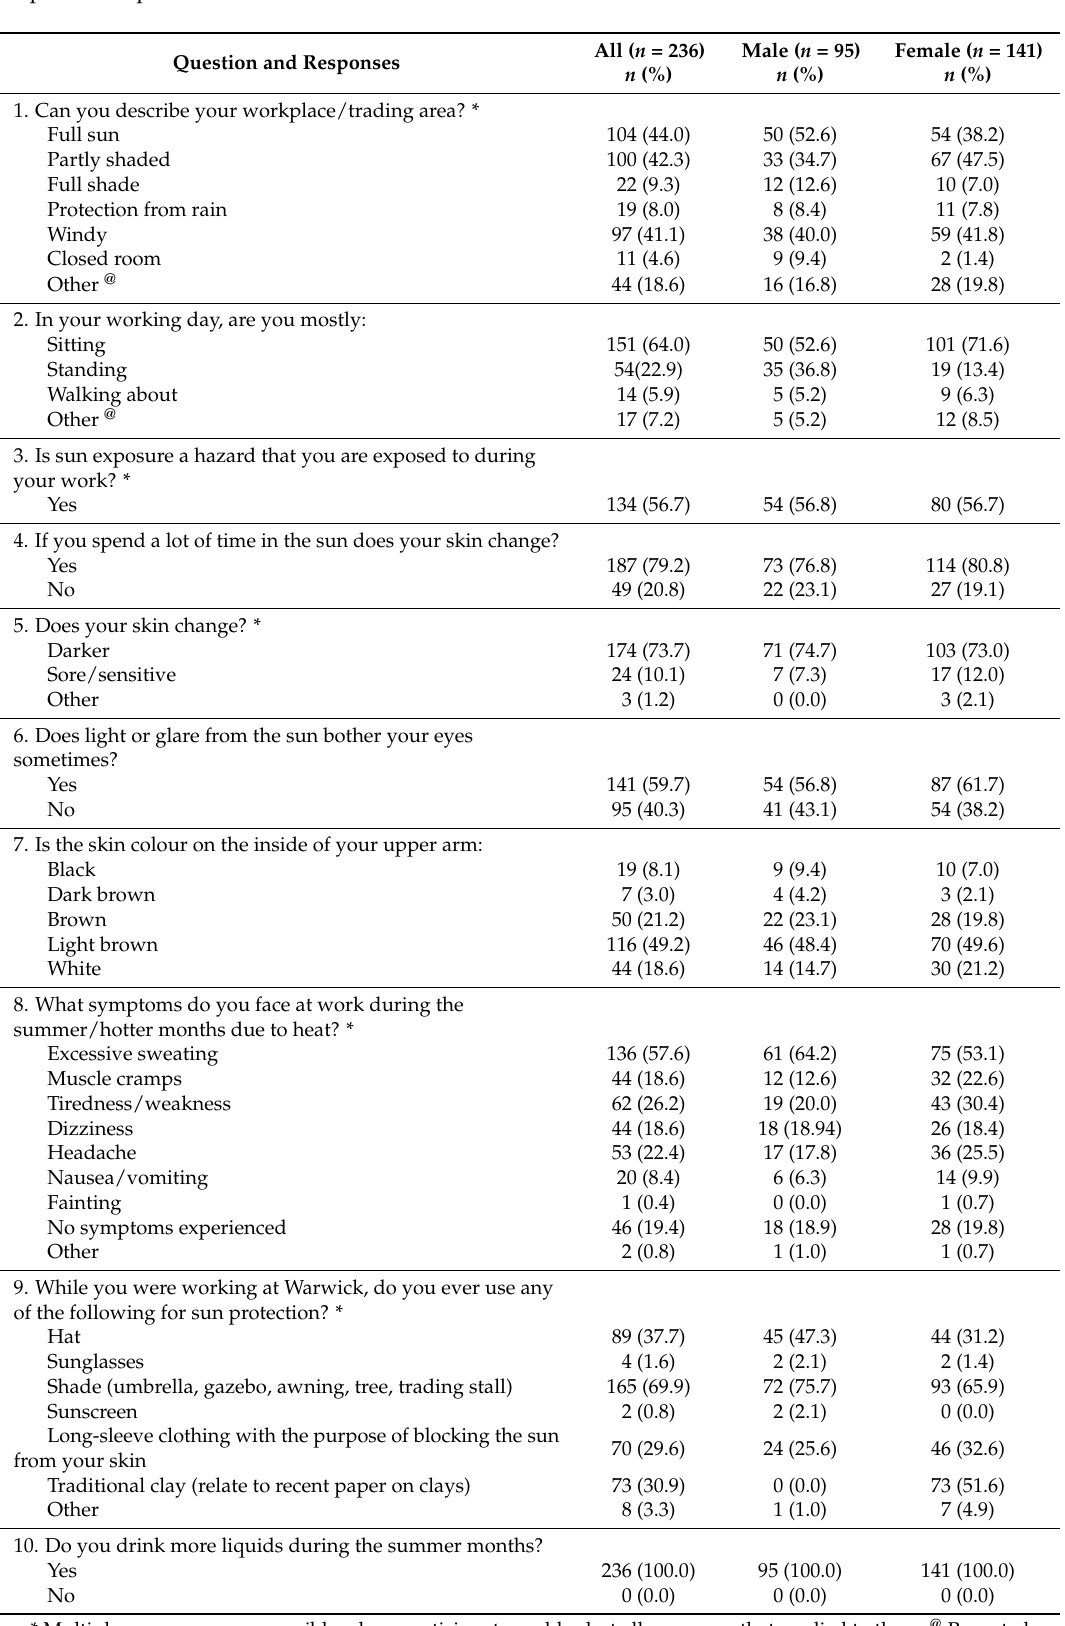
Table 2. Questions and responses to questions on sun exposure, sun-related symptoms, and sun protection